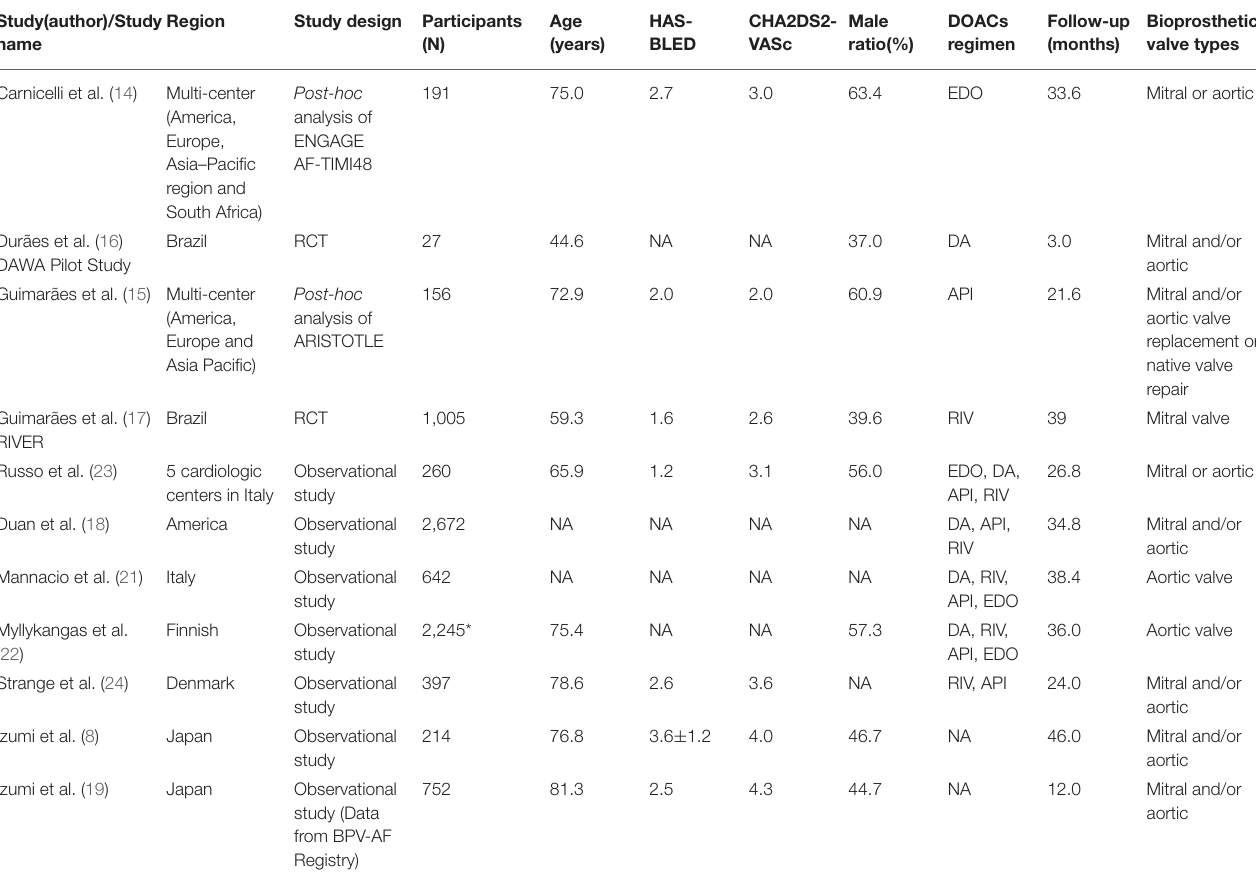
TABLE 1 | Baseline characteristics of the included studies in this